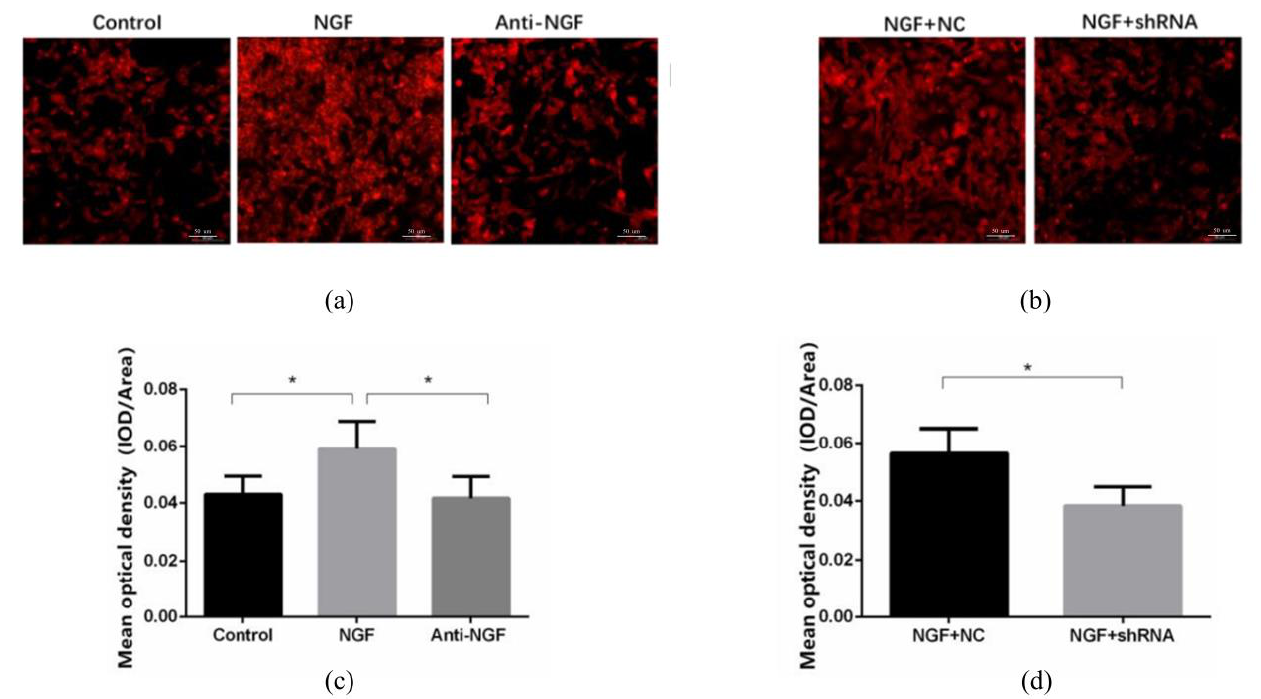
Figure 6. FM1-43 fluorescent staining was used to detect the vesicle release in SH-SY5Y neurons for Control group, NGF group, Anti-NGF group, NGF + NC group, and NGF + Atp6v0a1 shRNA group. ( a , b ) FM1-43 fluorescent staining imaging ( × 200). ( c , d ) Comparison of FM1-43 fluorescence intensity (Data are presented as mean ± SD. *: p < 0.05).